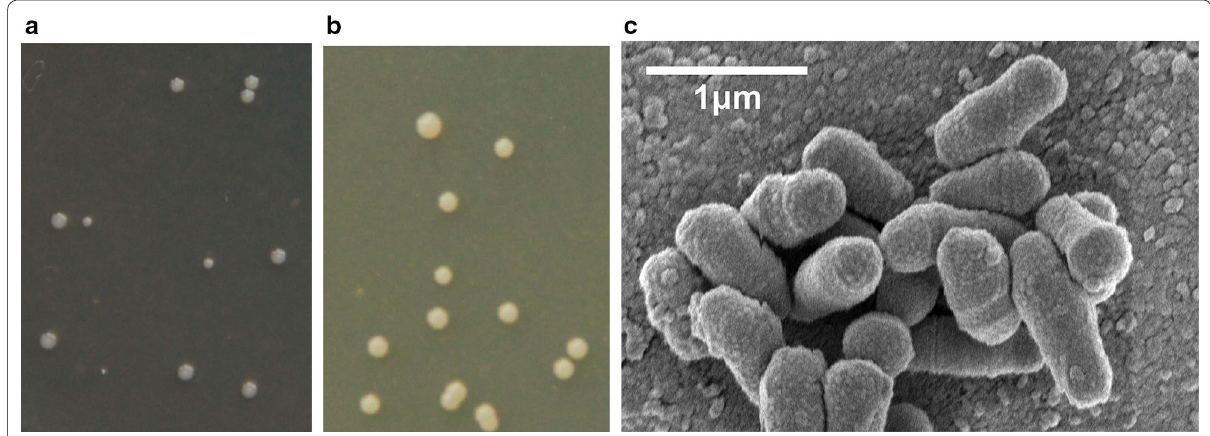
Fig. 1 Colonies and scanning electron micrograph of strain DW-1. a Colonies of strain DW-1 grown in MSM agar plate with 3-hydroxypyridine. b Colonies of strain DW-1 grown in LB agar plate. c Scanning electron micrograph of cells of strain DW-1. Bar, 1